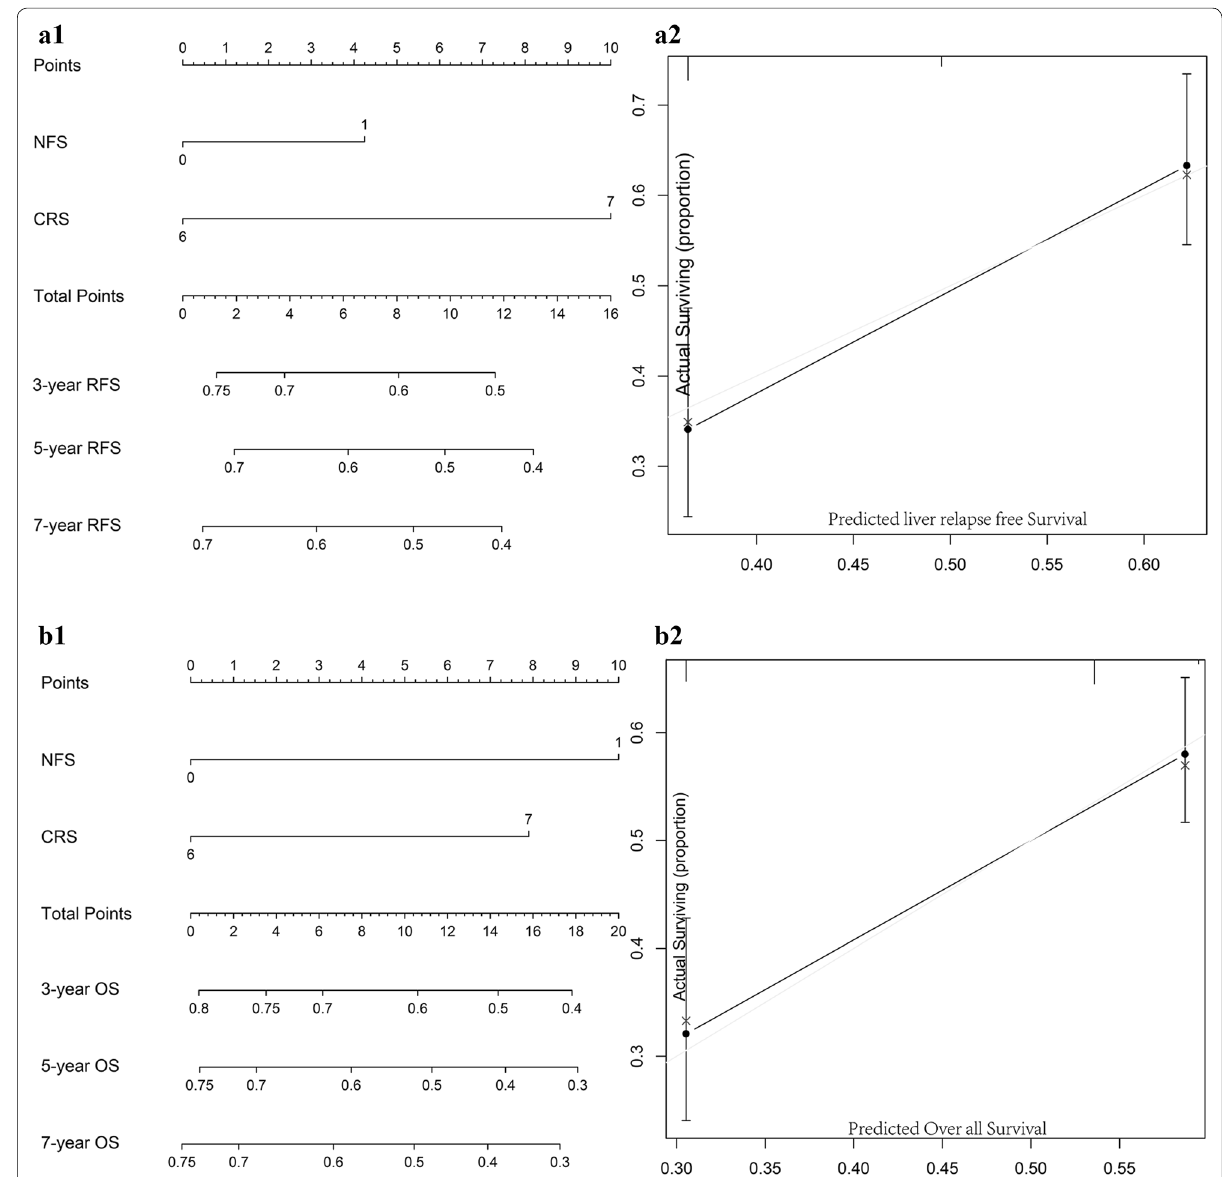
Fig. 6 Construction of liver fibrosis score nomogram to estimate hepatic RFS and OS, along with the assessment of the model calibration. a1 nomogram for liver RFS, a2 Calibration curves for liver RFS. b1 nomogram for OS, b2 Calibration curves for